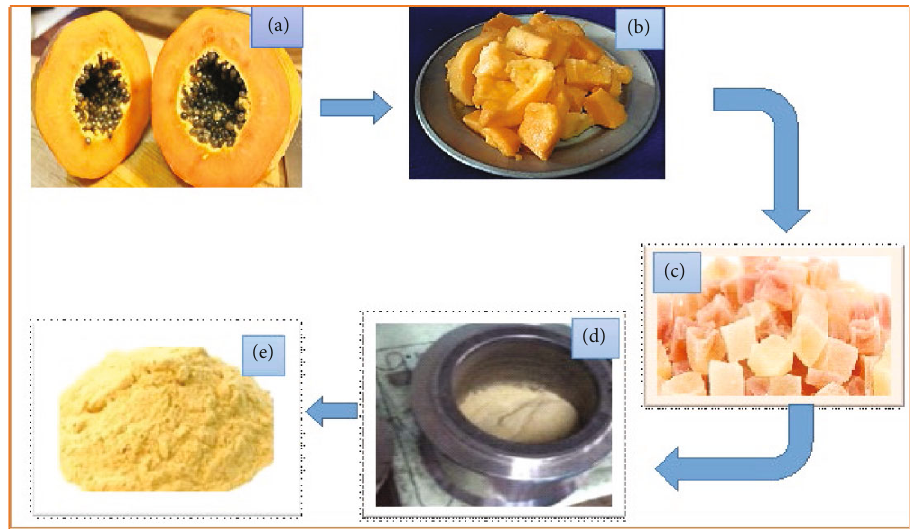
Figure 2: Papaya slice powder preparation. (a) Papaya fruit, (b) extracted slices, (c) sundried slices, (d) ball milling of papaya slice, and (e) papaya slice